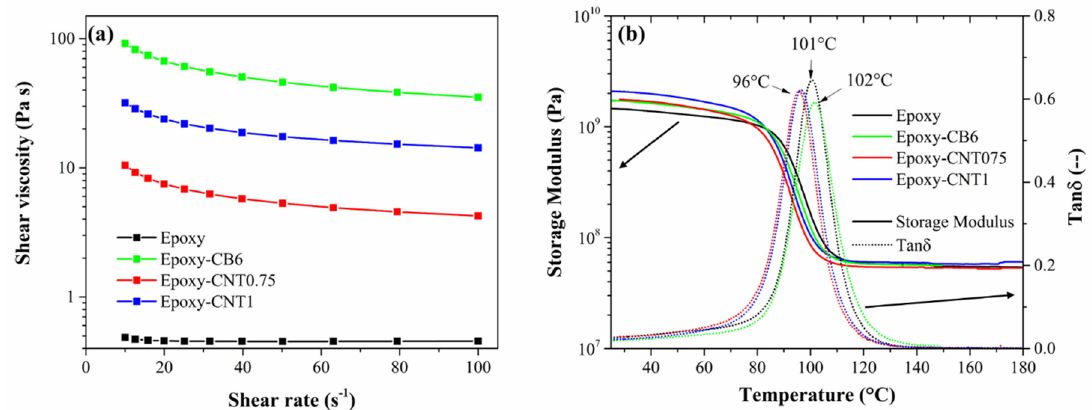
Figure 3. ( a ) Rheological results and ( b ) storage modulus (solid lines) and loss factor (tan δ , dotted lines) as function of temperature for resin systems. Table 3. DMA results of bulk cured resin and electrical resistance of impregnated SMP for each resin